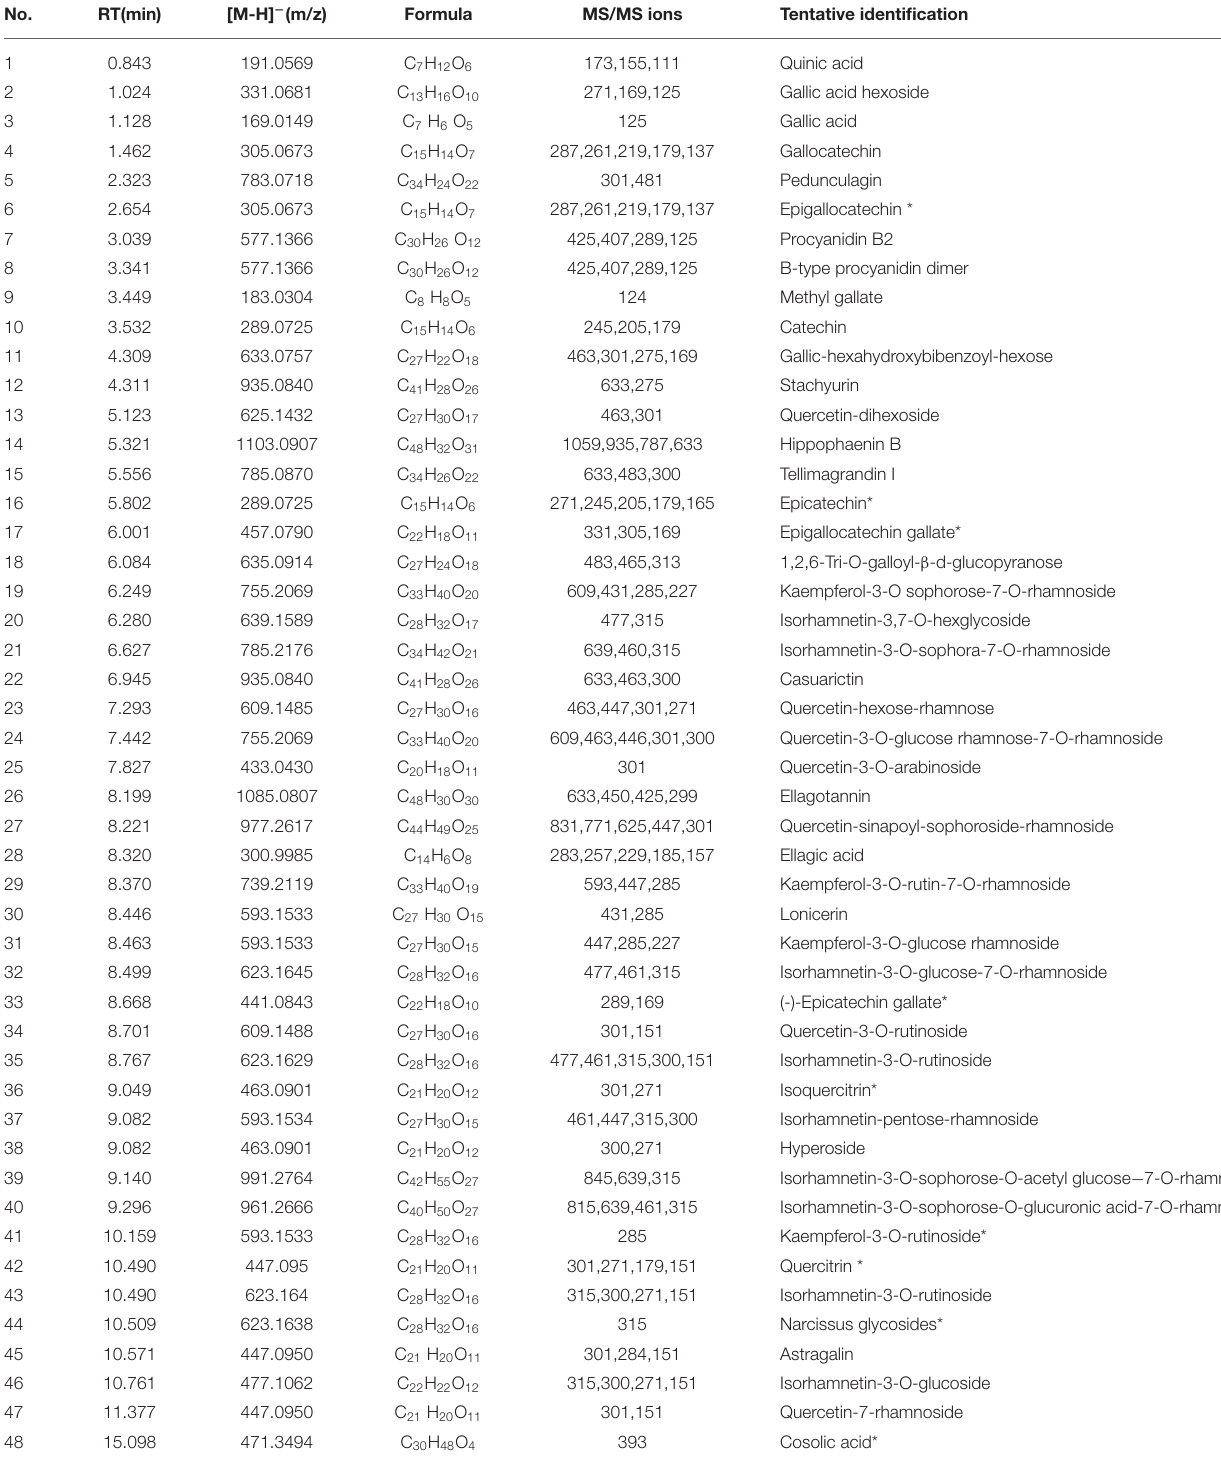
TABLE 1 | Information of main nonvolatile compounds from sea buckthorn leaves tea. No. Formula MS/MS ions Tentative